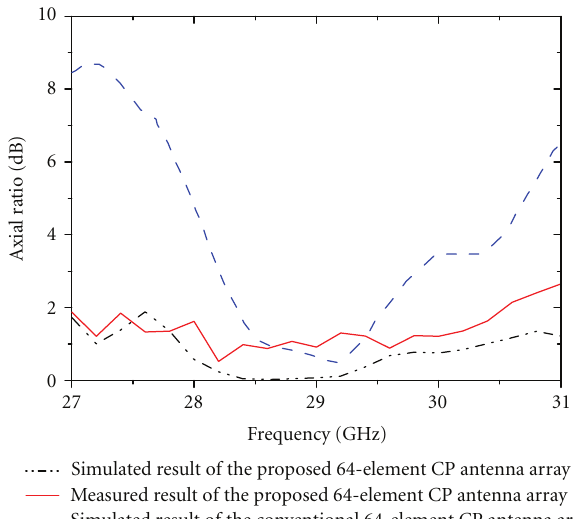
Figure 12: Measured and simulated axial ratio of the 64-element CP antenna arrays.